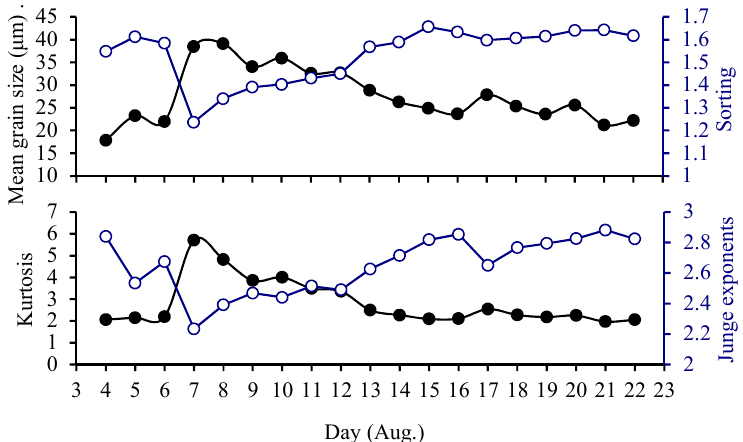
Figure 8. Variations in the average particle size, sorting, kurtosis and Junge-type power law slope obtained from the sediment trap sample during the passage of typhoon Muifa on August 8, 2011.